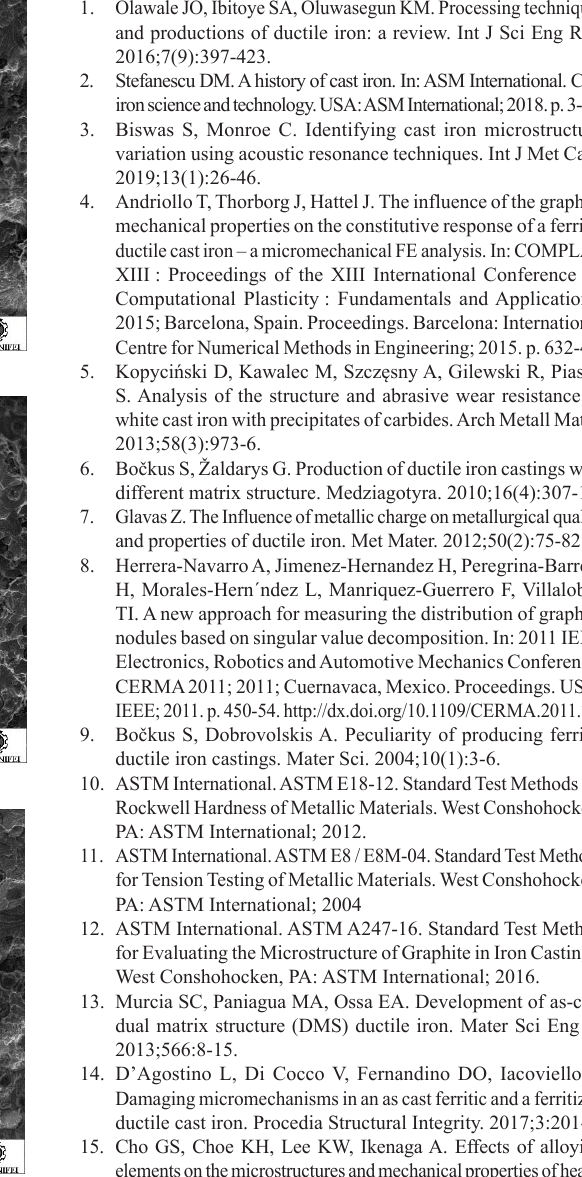
Figure 39. Fractured surface of Ni/Mo.